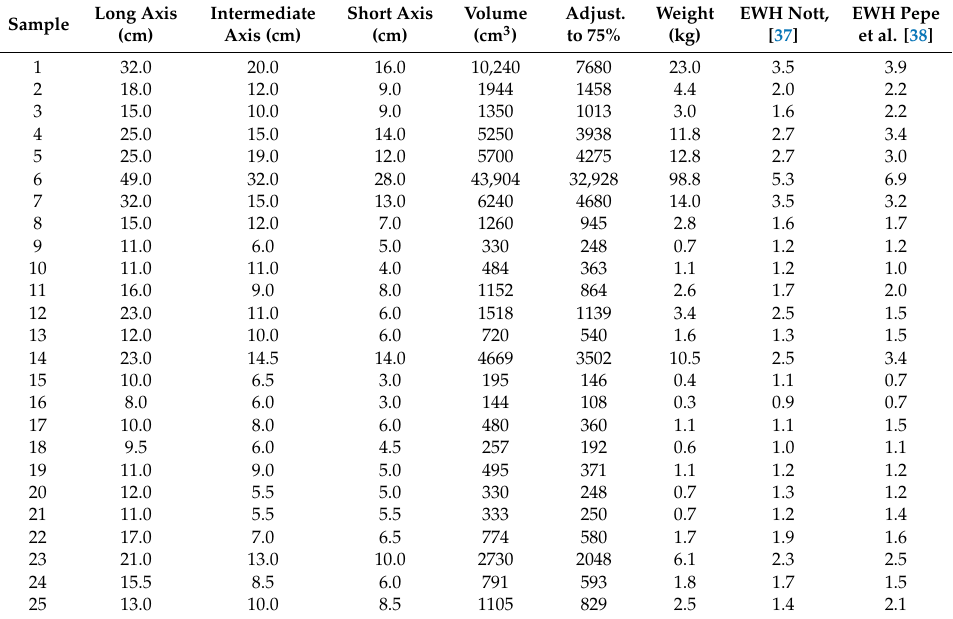
Figure 8. Pleistocene (MIS 5e) conglomerate 9 m above mean sea level at Ponta do Cedro (site 6). Raw data on clast size in three dimensions collected from three study sites at this locality are available in Tables 5–7. Table 5. Quantification of boulder size, volume, and estimated weight from the Pleistocene (MIS 5e) conglomerate at site 5 at Ponta do Cedro, on the east shore of Santa Maria Island (see map, Figure 1b). The standard density of basalt at 3.0 gm / cm 3 was applied uniformly in order to calculate wave height for each boulder. EWH: estimated wave height (in meters), calculated from equations in Nott [37] and Pepe et al. [38]. See the methods Section 3.2. (hydraulic model).